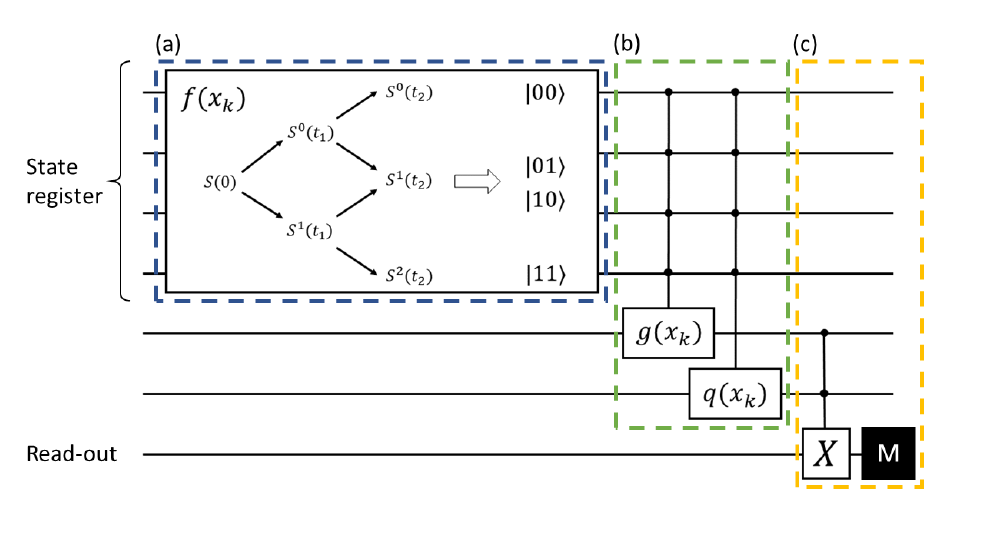
Figure 1. A visualization of the upcoming algorithm as a quantum circuit model. The horizontal lines represent the used qubits. The black circles show the function’s dependence on the respective qubits. ( a ) The given valuation tree is mapped to a qubit register, encoding in the qubit states the asset’s path values x k . The underlying’s path probabilities f ( x k ) are associated with the qubit’s state probabilities. ( b ) Depending on the path, the payoff g ( x k ) and indicator function q ( x k ) are implemented on different qubits. ( c ) The functions are combined on a read-out qubit and finally